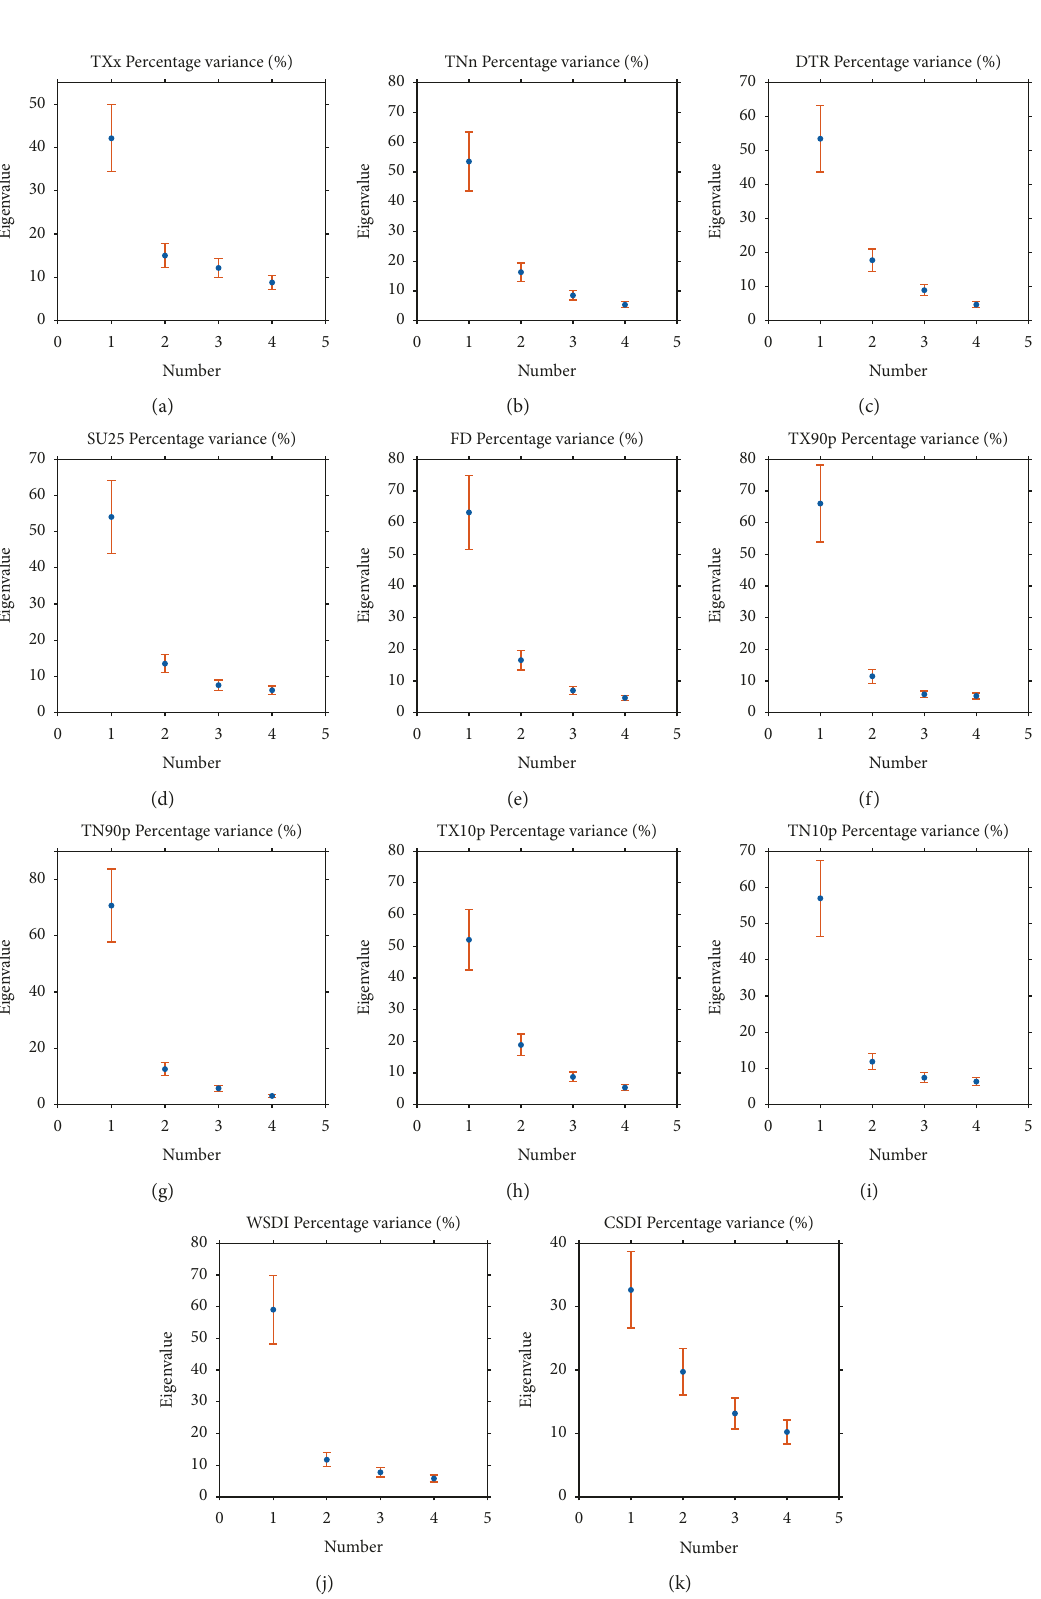
Figure 3: Characteristic root of extreme temperature and 95% confidence